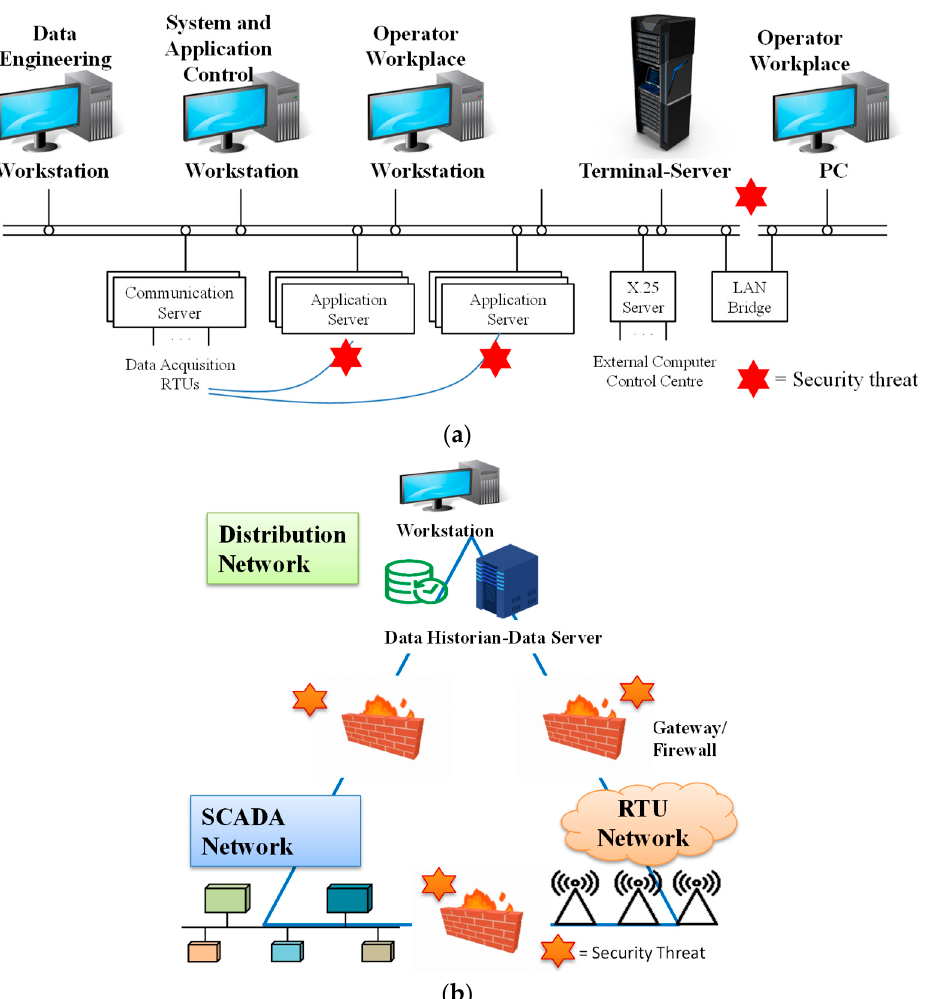
Figure 2. Prospective security threat in ( a ) Supervisory Control and Data Acquisition (SCADA) network ( b ) Gateway/firewall of internal network .